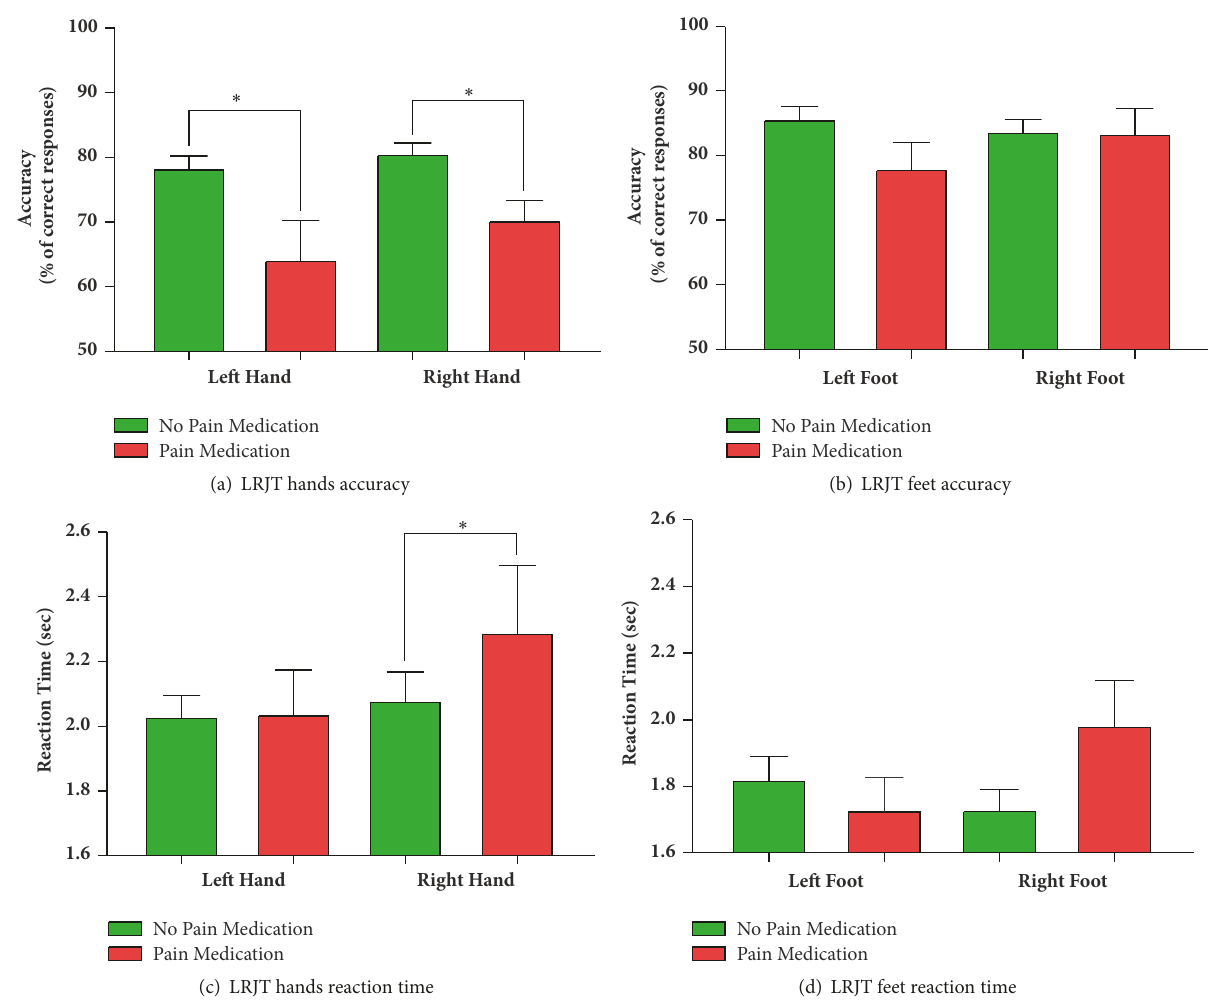
Figure 2: Left Right Judgement performance accuracy and reaction time in participants who were taking pain medication (PainMeds) and not taking pain medication (NoPainMeds) on the day of the evaluation. x ± 95% Confidence Intervals. ∗ False Discovery Rate Statistical significance below 𝛼